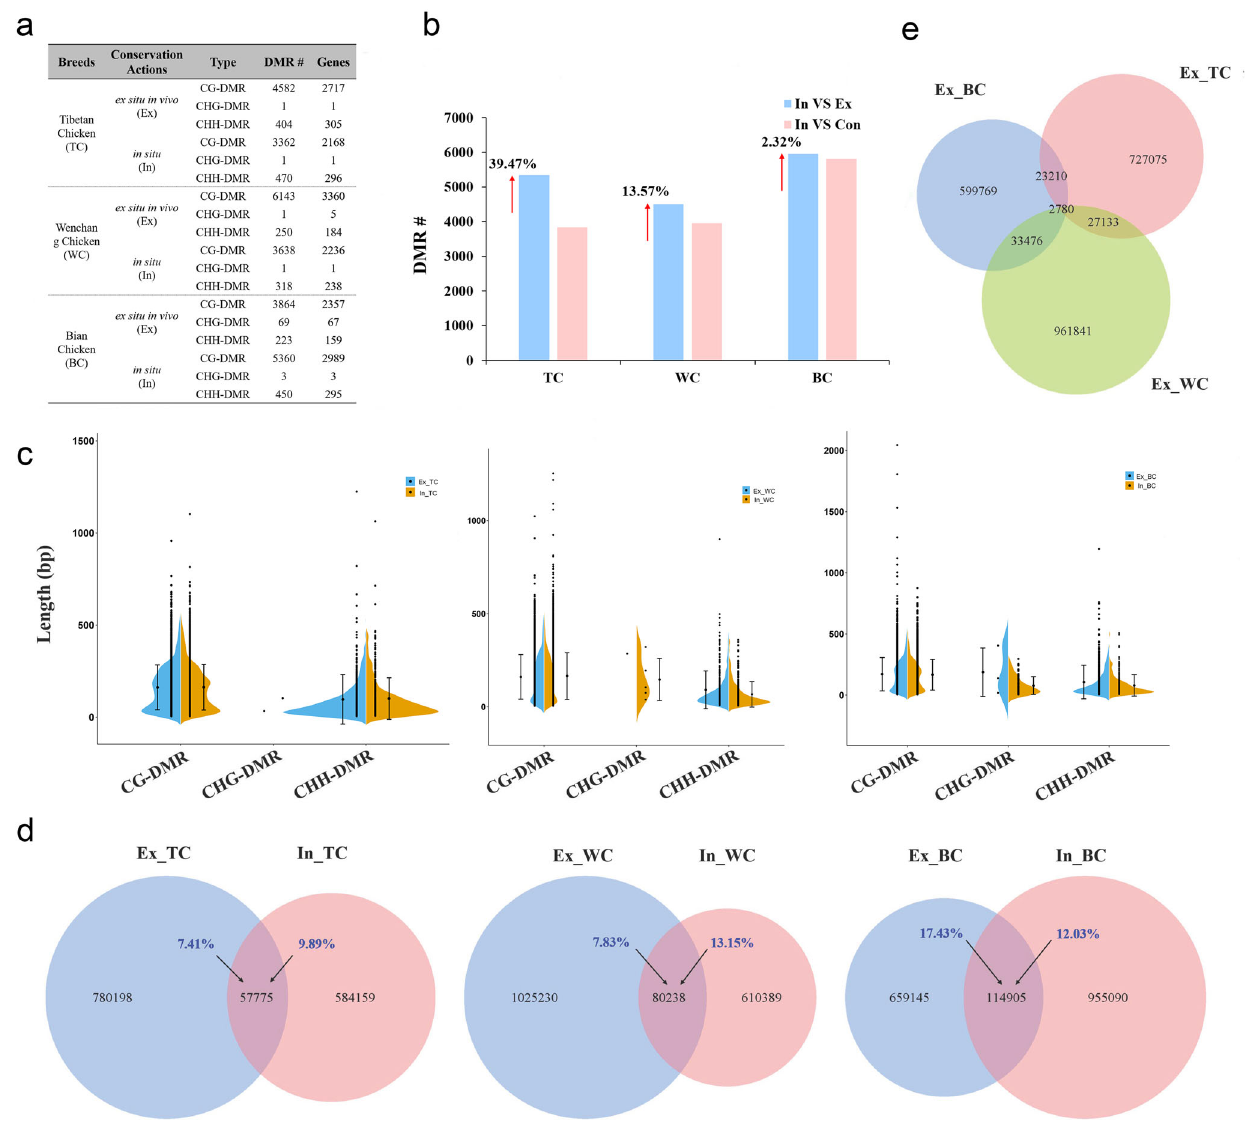
Fig. 4 Differentially methylated regions (DMRs) during in situ (In) and ex situ in vivo (Ex) conservation programmes of chickens. a Number of DMRs detected in different conservation programmes of three indigenous chicken breeds. b Change in numbers of DMRs detected between Ex and In of three indigenous chicken breeds. c Length of DMRs during different conservation programmes of three indigenous chicken breeds. d Venn diagram of the numbers of overlapping bases in DMRs during different conservation programmes of three indigenous chicken breeds. Overlapping areas are presented as percentages. e Overlapping bases (bp) in DMRs during Ex conservation of three indigenous chicken